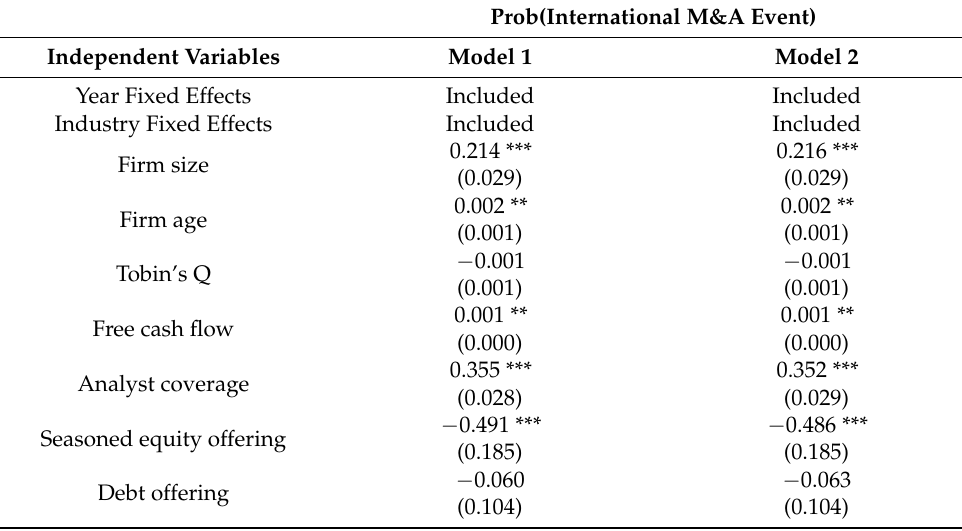
Table 3. Cox Regression Results for All Manufacturing Firms’ International